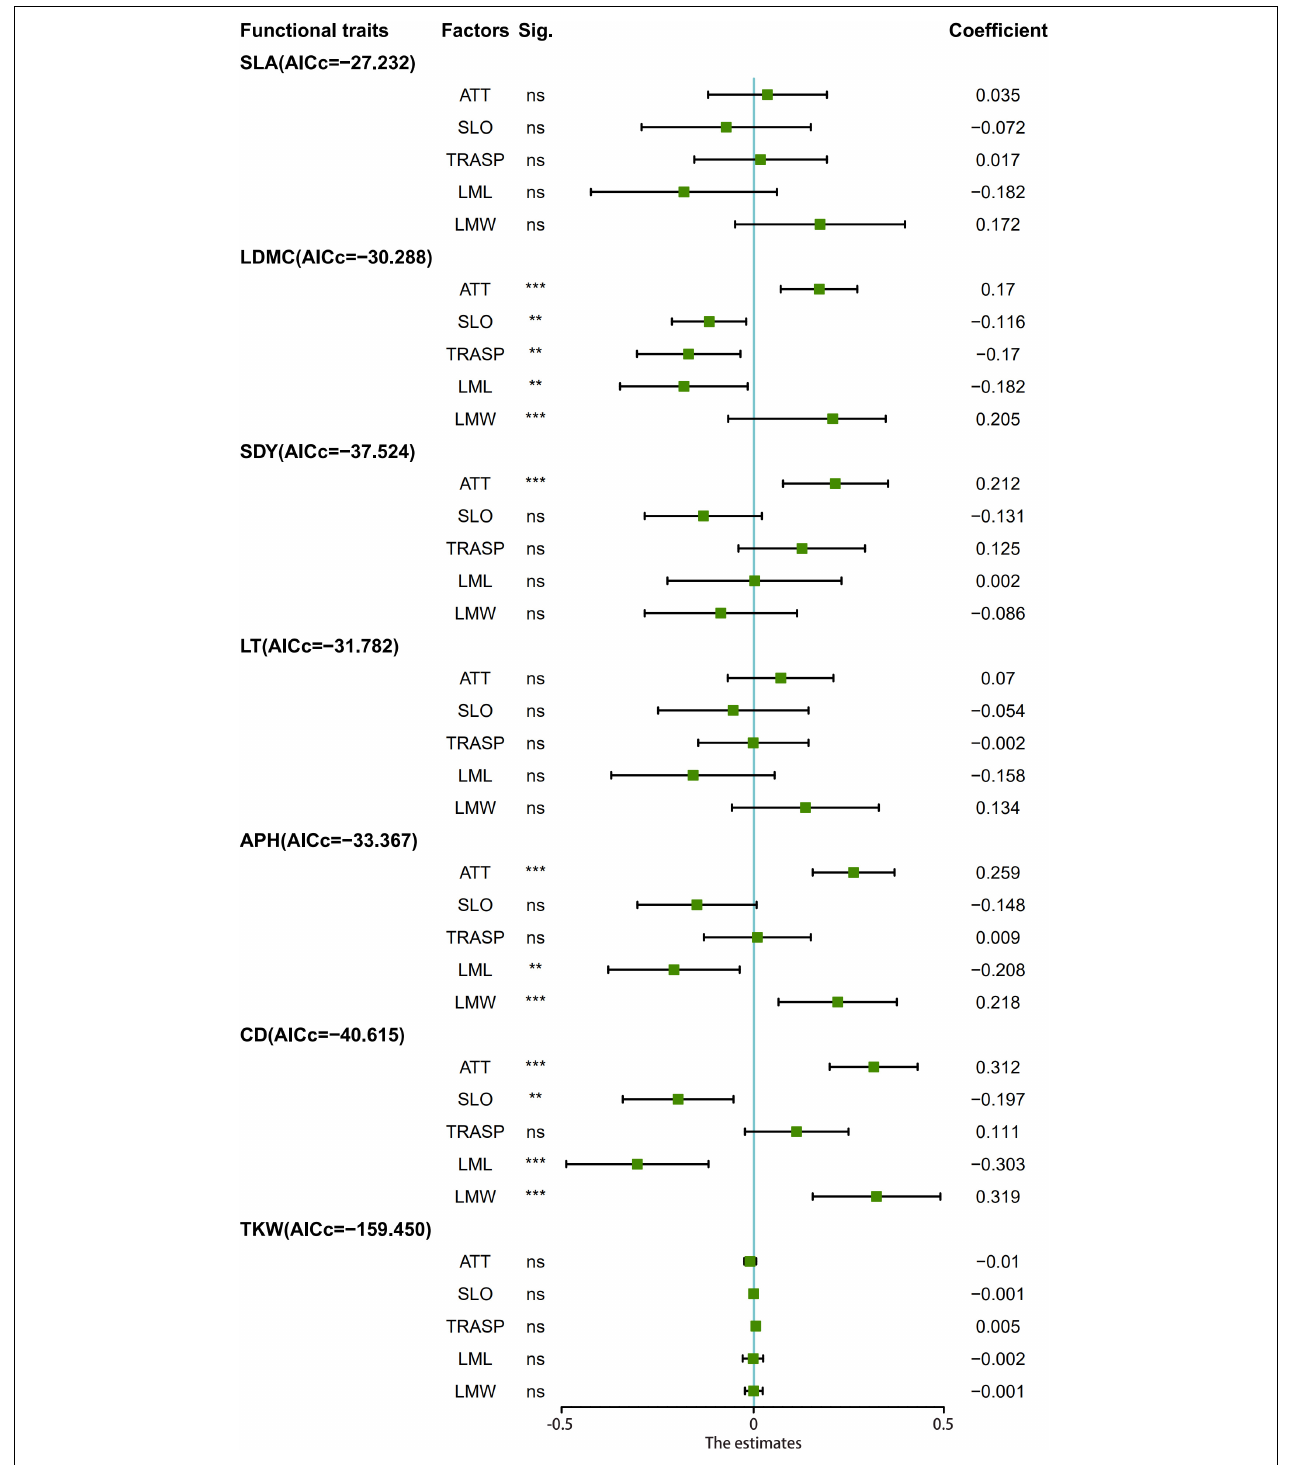
FIGURE 9 | Generalized linear mixed model (GLMM) model coefficient estimates and 95% confidence intervals showing the influence of the geographical environmental attributes of landslide no the shrub functional traits. SLA, specific leaf area; LDMC, leaf dry matter content; SDY, stem density; LT, leaf thickness; APH, average plant height; CD, crown diameter; TKW, thousand kernel weight; **, significant at the 0.05 level; ***, significant at the 0.01 level; ns, non-significant.